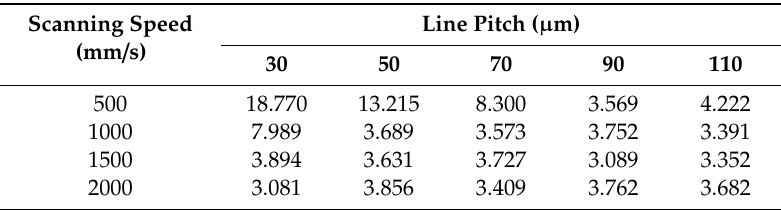
Table 4. Root mean square height (Rq) of mesh patterns on the XO RGP contact lens treated by different laser scanning speeds and line pitches (Unit: μ m).